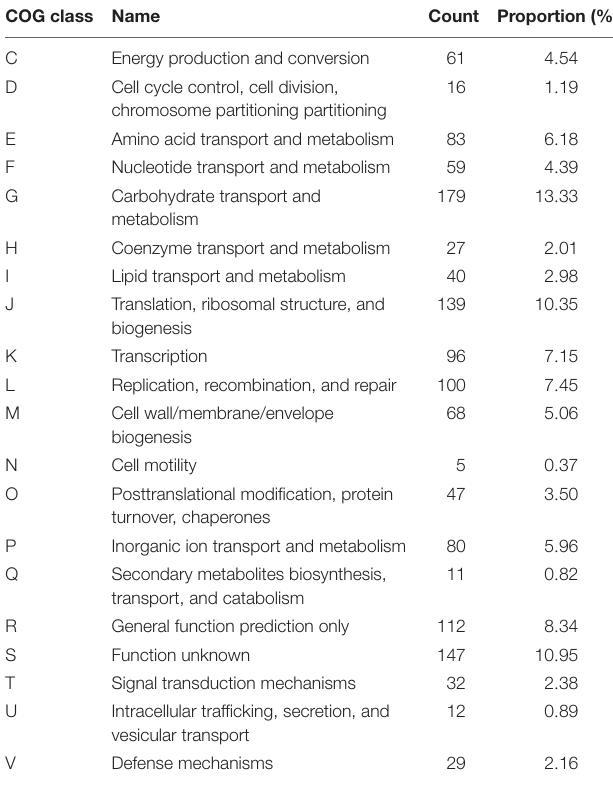
TABLE 3 | COG categories of coding proteins in Enterococcus faecalis Gr17 genome.